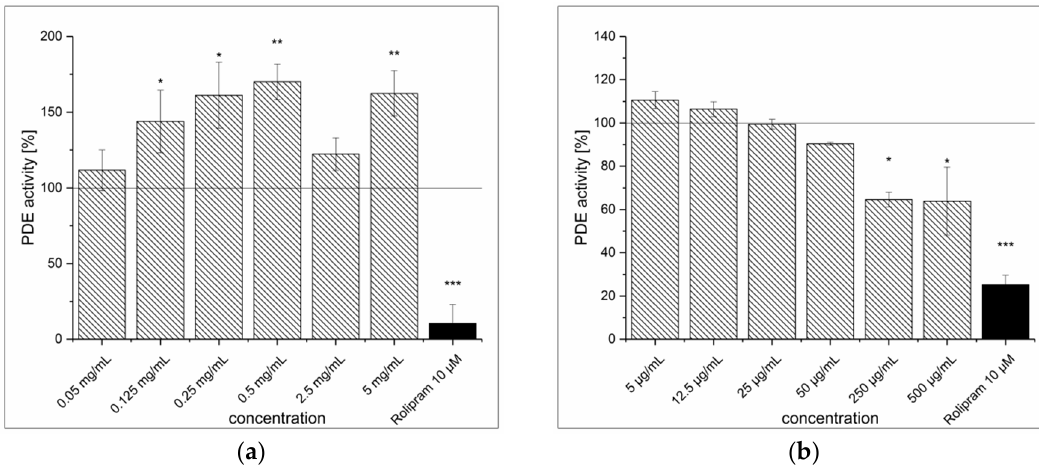
Figure 3. cAMP ‐ specific phosphodiesterase (PDE) activity following incubation with green tea extract (TXE) ( a ) and caffeine ( b ). Data are presented as the mean ± standard deviation of three independent experiments. The significance of differences between sample and control was assessed with a Student’s t ‐ test. Confidence intervals: * p < 0.05; ** p < 0.01; *** p < 0.001.